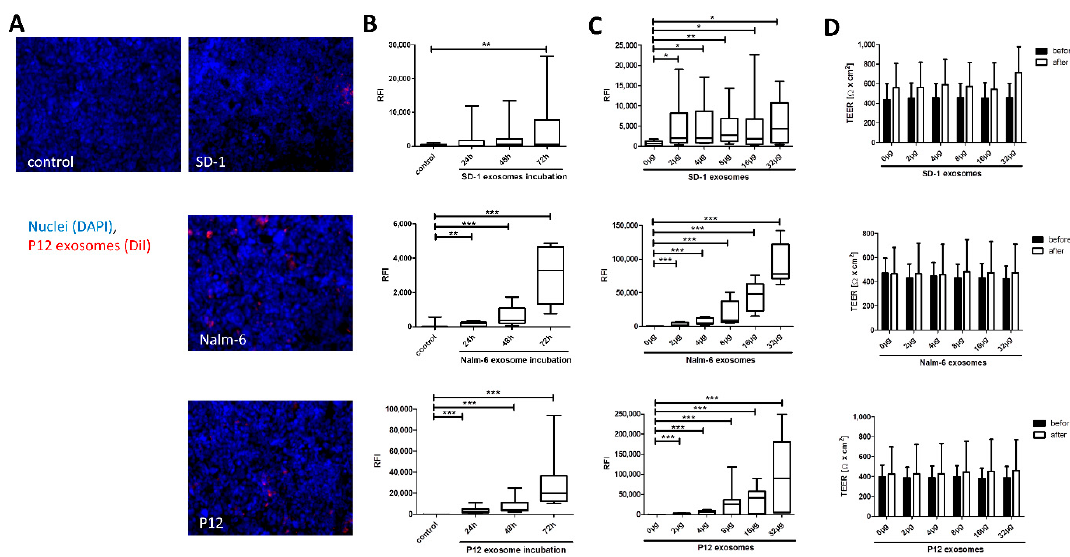
Figure 1. Time- and dose-dependent uptake/binding of acute lymphoblastic leukemia (ALL) exosomes to blood-cerebrospinal fluid barrier (BCSFB) in vitro model. Fluorescently labeled exosomes were added onto the basolateral side of HiBCPP cells grown in inverted culture as indicated and uptaken / bound exosomes were quantified by fluorescent microscopy. Relative fluorescence intensity (RFI) was measured in 15 fields of view (20 × objective). ( A ) Representative observation field of untreated control HiBCPP cells and HiBCPP cells incubated with DiIC18(3) labeled exosomes (red) (16 µ g, 48 h). HiBCPP cells were visualized by nuclei staining (DAPI, blue). ( B ) Time-dependent uptake / binding of ALL-derived exosomes (16 µ g per filter; SD-1, Nalm-6, and P12, respectively) for indicated time points from basolateral side, and ( C ) dose-dependent uptake / binding of ALL-derived exosomes (48 h; SD-1, Nalm-6, and P12, respectively) for indicated amounts per filter from